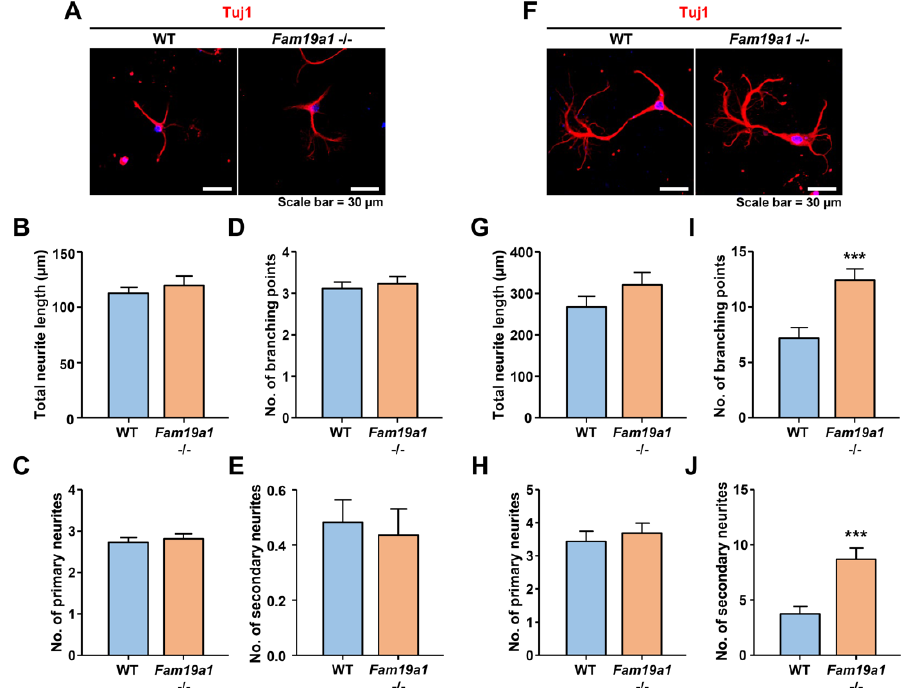
Figure 5. Abnormal neurite formation in Fam19a1 − / − primary hippocampal neurons. ( A – E ) Primary hippocampal neurons at days in vitro 3 (DIV 3). ( A ) Representative images of WT and Fam19a1 − / − neurons at DIV 3. Neuronal morphologies were analyzed in terms of total neurite length; ( B ), total number of primary neurites; ( C ), total number of branching points; ( D ), and total number of secondary neurites; ( E ). ( F – J ) Primary hippocampal neurons at days in vitro 6 (DIV 6). ( F ) Rep- resentative images of WT and Fam19a1 − / − neurons at DIV 6. Neuronal morphologies were analyzed in terms of total neurite length; ( G ), total number of primary neurites; ( H ), total number of branching points; ( I ), and total number of